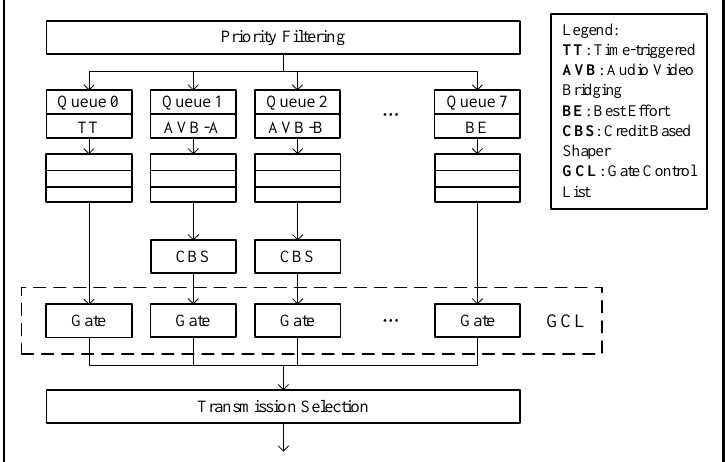
Figure 1. Transmission mechanism of Time-Aware Shaper in IEEE 802.1Qbv.